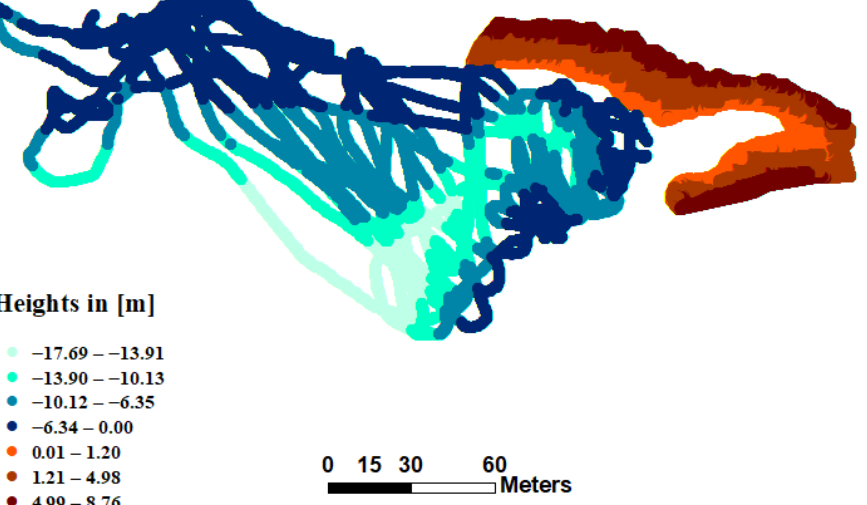
Figure 11. Merged measurements including topographic and bathymetric data.